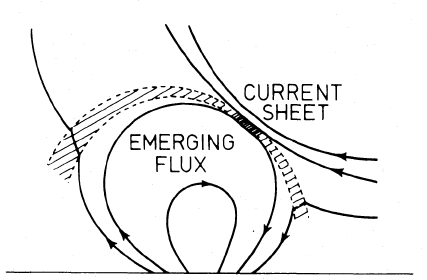
Figure 47: A model of solar flares produced by magnetic reconnection between the emerging flux and the pre-existing field. Image reproduced with permission from Heyvaerts et al. (1977), copyright by AAS. The first MHD simulation of magnetic reconnection between the emerging flux and pre-existing field was done by Forbes and Priest (1984). In this paper the emerging flux was driven in from the bottom boundary of the computational domain, which initially consisted of uniform, horizontal magnetic field with opposite direction to the emerging flux. They found that, because the emer- gence is slower than the Alfv´en time-scale 𝜏 𝐴 but faster than the reconnection time-scale given by the Sweet–Parker reconnection model 𝜏 ∼ 𝑆 1 / 2 𝜏 𝐴 , where 𝑆 is the Lundquist number, a region of closed loops and a current sheet at the top of the loop are formed. In the later phase reconnection became faster and super-magnetosonic flows (jets) were produced. Thus, the model by Heyvaerts et al. (1977) shown in Figure 47 was demonstrated by MHD